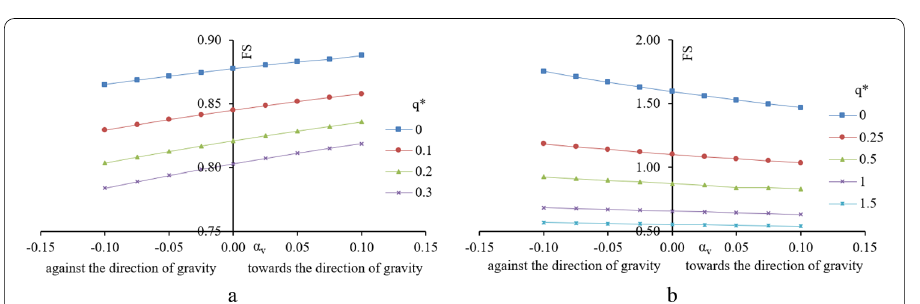
Fig.9 FS vs α v on different values of q*: (a) case 1 and (b) case